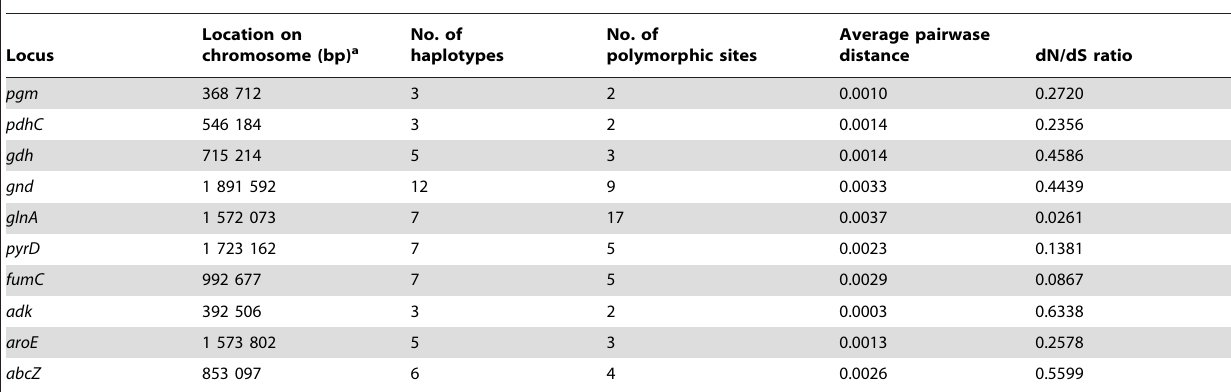
Table 2. Genetic characteristics of gonococcal